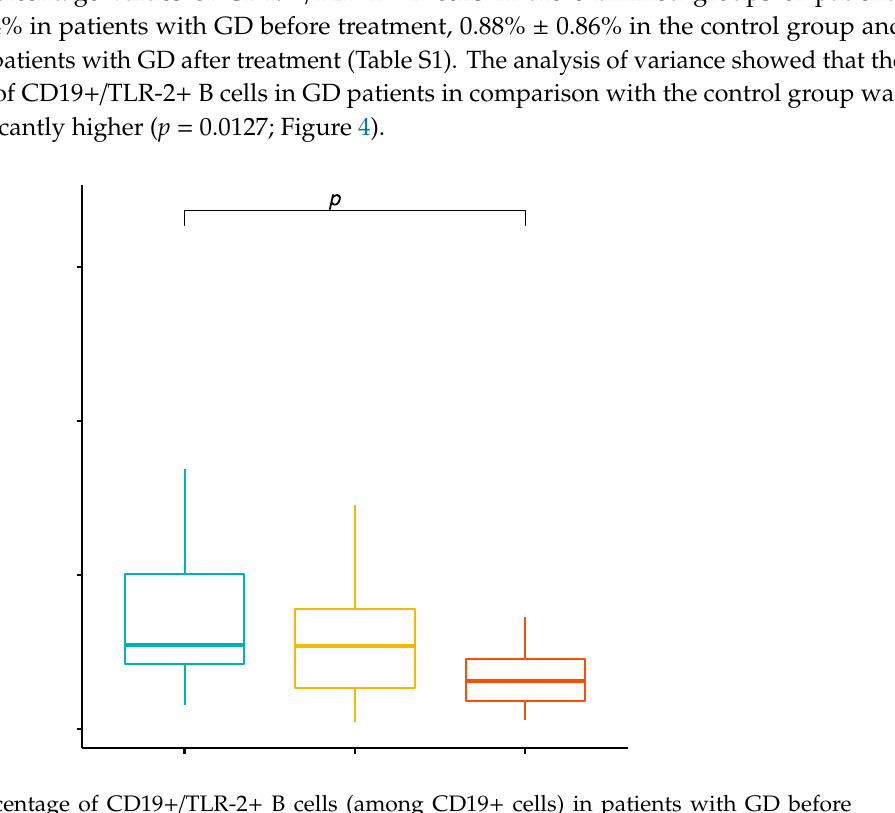
Figure 3. The expression level of TLR-2 on CD8+ T cells (mean fluorescence intensity—MFI) in patients with GD before treatment, after euthyroidism and in the control group. 2.5. Comparison of the Percentage Values of CD19+/TLR-2+ B Cells in Patients with GD before Treatment, after Treatment and in the Control Group